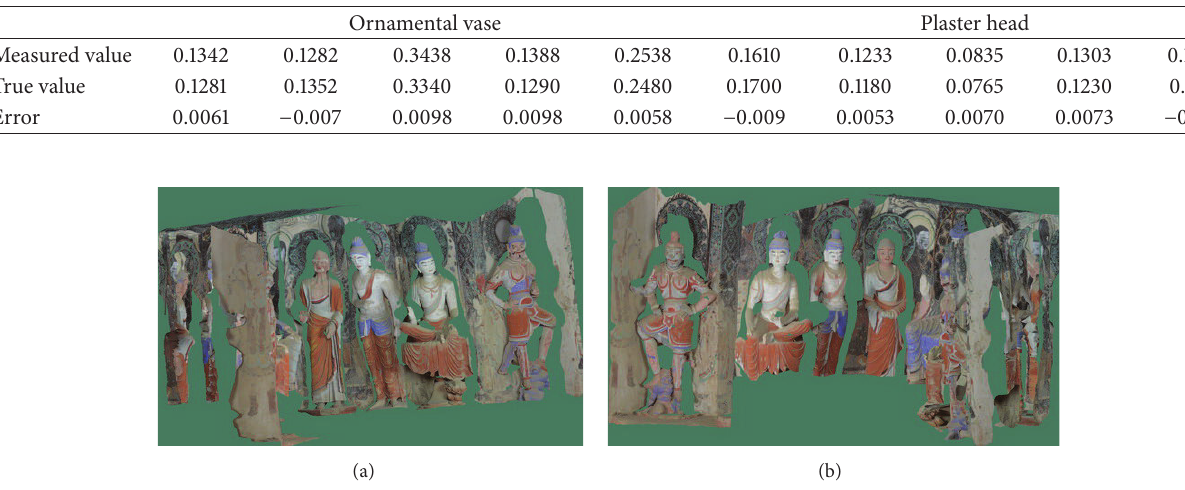
Table 1: Quantitative analysis of reconstruction results (unit: meters).